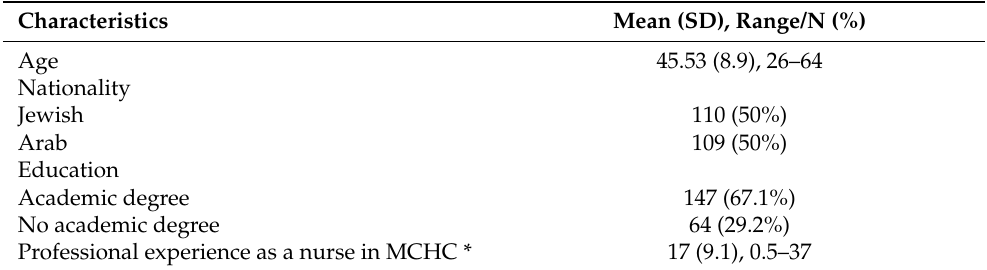
Table 1. Background characteristics of nurses who participated in the study (N = 219).